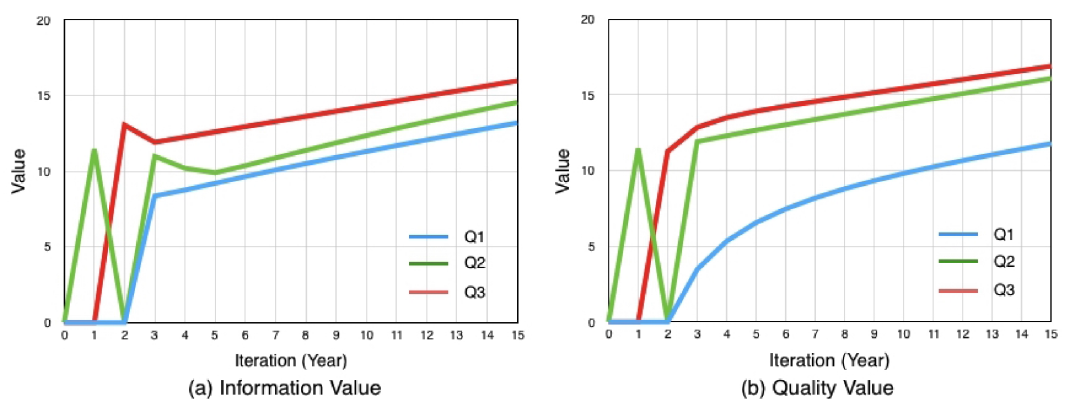
Figure 5. Value Generated in Design Stage: (a) Information Value, (b) Quality